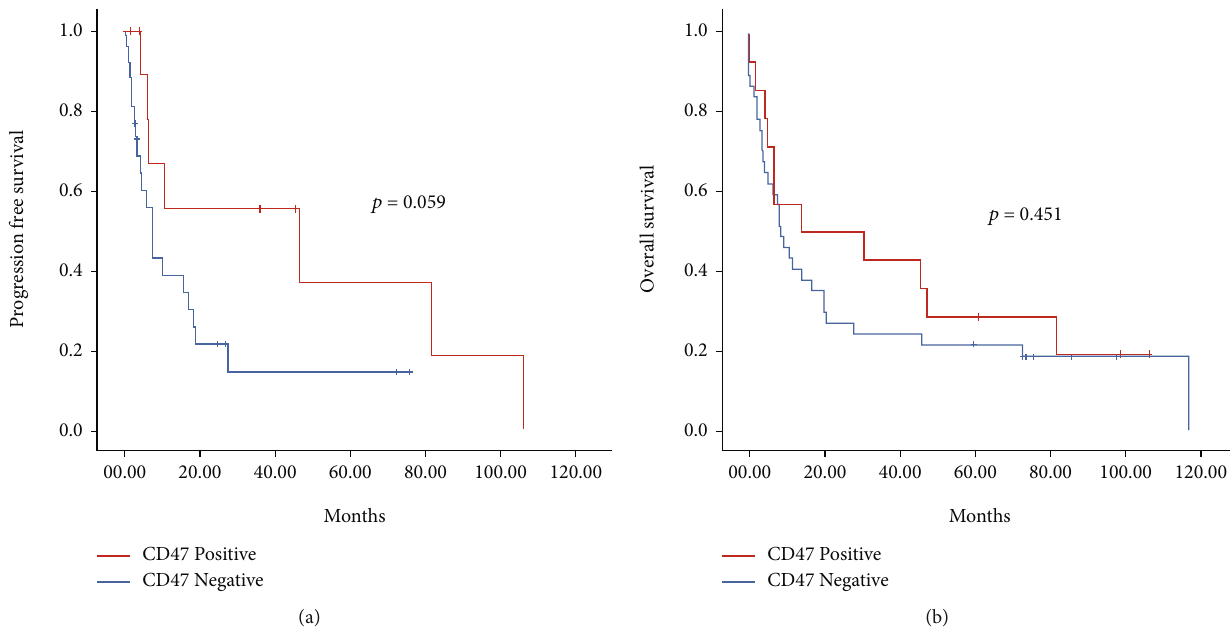
Figure 2: PFS (a) and OS (b) according to CD47 expression of the entire